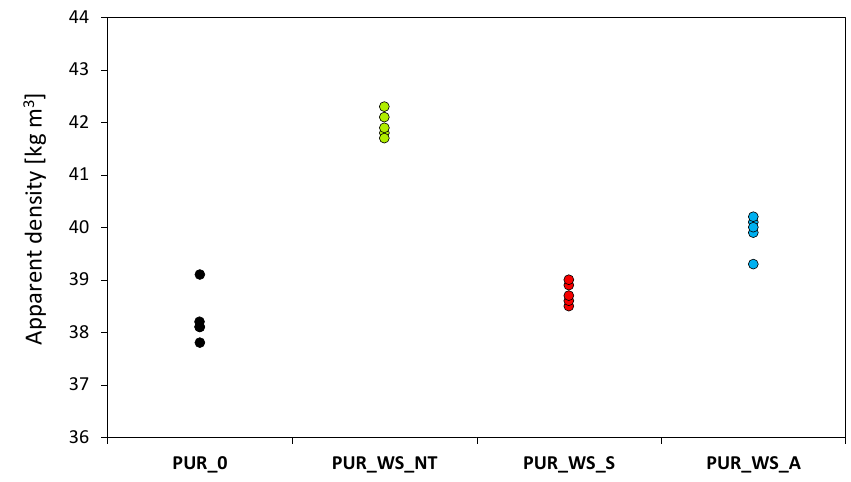
Figure 6. The apparent density of PUR_0, PUR_WS_NT, PUR_WS_S, and PUR_WS_A.